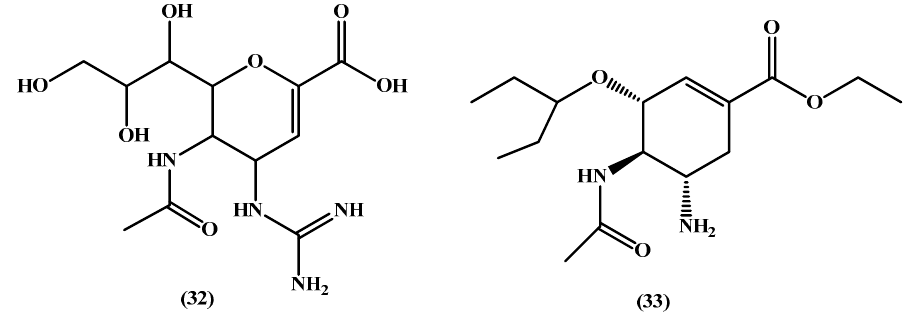
Figure 16. Chemical structures of zanamivir ( 32 ) and oseltamivir ( 33 ).